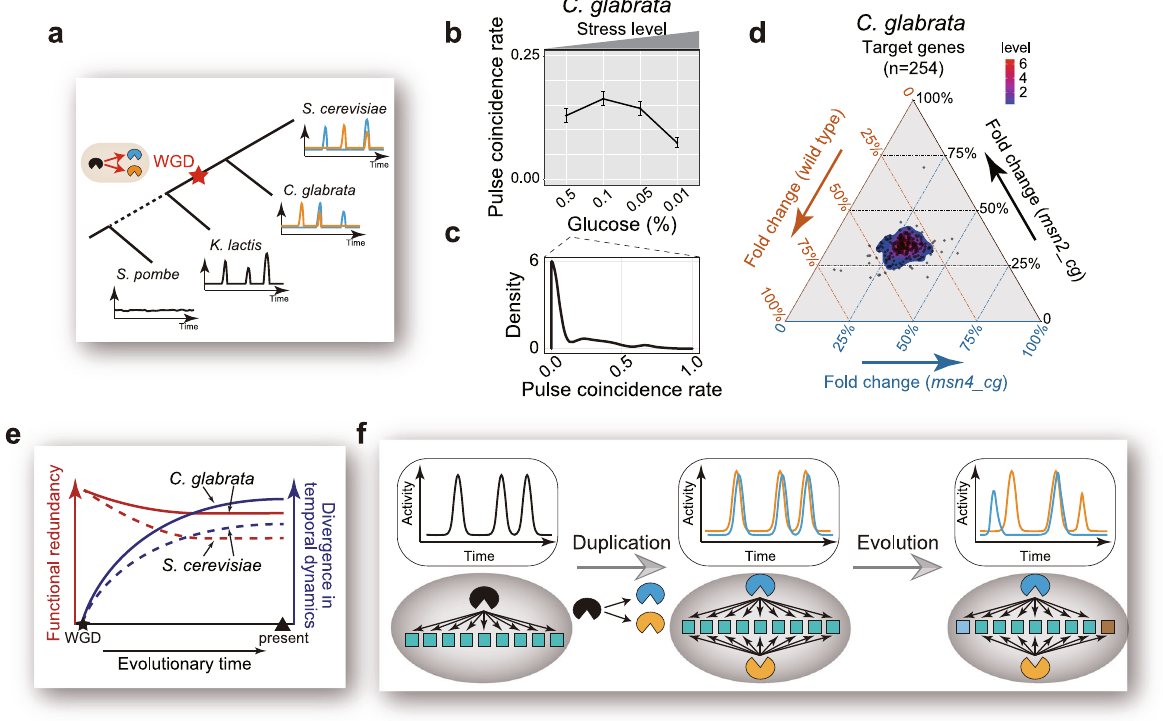
Fig. 5 Evidence supporting the evolutionary role of temporal redundancy modulation. a Evolution of pulsatile dynamics of Msn2/4 orthologs in different yeast species. See also Supplementary Fig. 11. b Pulse coincidence rate between Msn2_cg and Msn4_cg in C. glabrata decreases as the glucose limitation stress increases. Cell numbers are 525, 652, 761, and 752. Error bars indicate 95% CIs and centers indicate means. c Pulse coincidence rate is bimodally distributed among single cells under the same stress level for C. glabrata . d Quanti fi cation of functional redundancy between Msn2_cg and Msn4_cg in C. glabrata through analogous experiments and analysis as in Fig. 2c. Msn2/4_cg target genes were identi fi ed by differential gene expression analysis (Supplementary Fig. 12d). e Proposed evolutionary trajectories of functional redundancy and temporal relationship between paralog dynamics for the Msn2/4 system in yeast. f Schematics illustrating the potential role of temporal redundancy modulation for the evolutionary preservation of paralogous redundancy. Prior to duplication (leftmost panel), the TF of interest exhibits pulsatile dynamics (top) and regulates a set of target genes (bottom). Immediately after duplication, paralogous TFs have high functional redundancy and highly correlated dynamics (middle panel). The subsequent acquisition of mechanisms for temporal redundancy modulation helps the maintenance of functional redundancy (rightmost panel). For each panel, the top half illustrates the temporal activity dynamics of the TF(s), while the bottom half illustrates the regulatory connections between TF(s) and targets. Colored squares represent shared or unshared targets of the